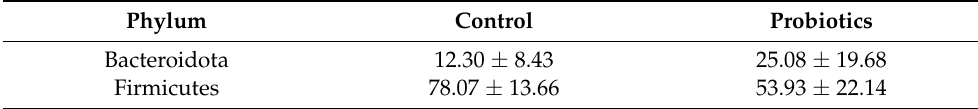
Table 1. Relative abundance of major flora at the phylum level (%).